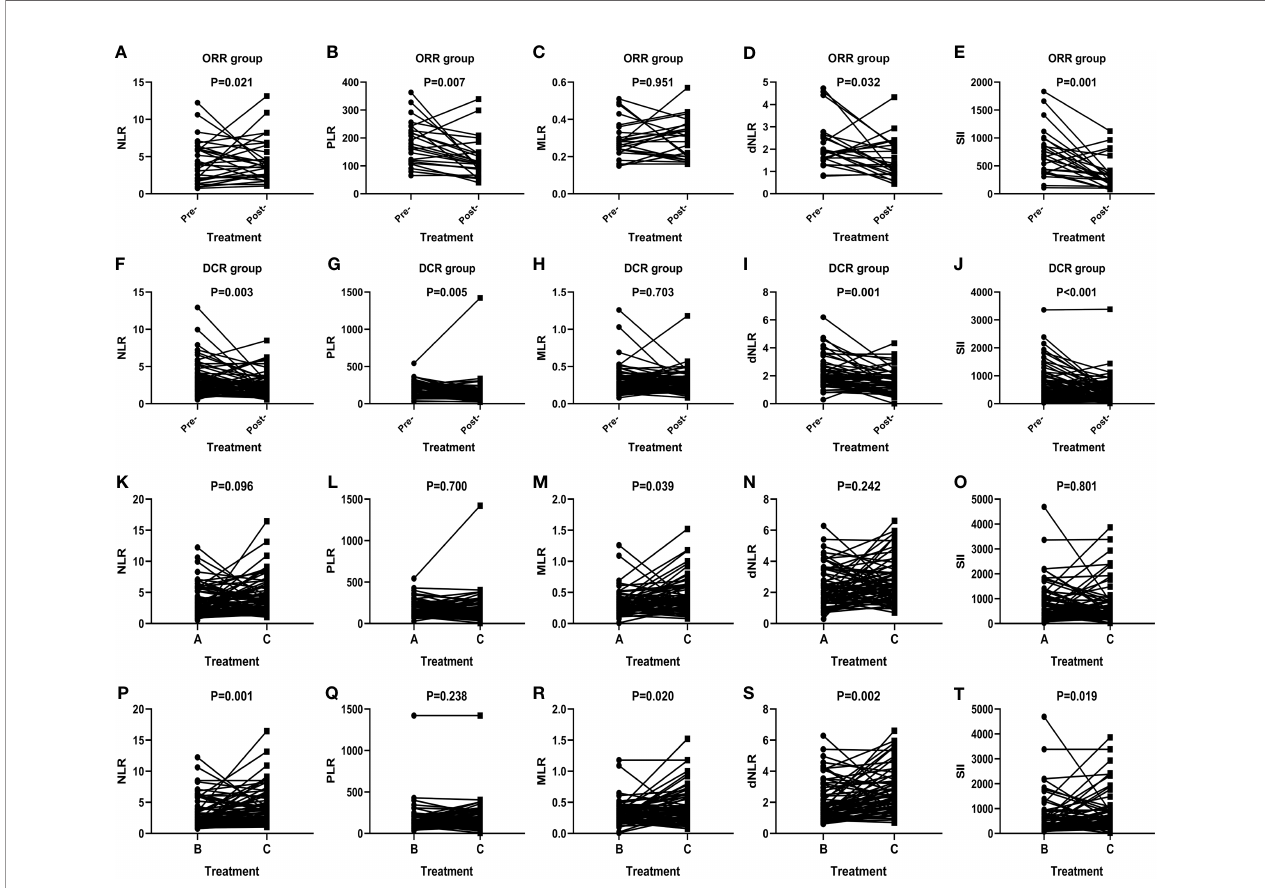
FIGURE 2 | Ef fi cacy of anti-PD-1 treatment according to the changes in in fl ammatory markers in AGC patients in the ORR group (A – E) , DCR group (F – J) , and subgroup analysis groups (K – T) . A: Levels of in fl ammatory markers in patients in the baseline. B: Levels of in fl ammatory markers in patients with optimal effects. C: Levels of in fl ammatory markers when disease progression.